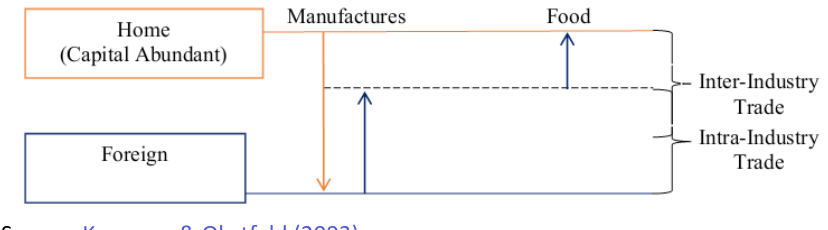
Figure 2: Patterns of Inter-Industry Trade and Intra-Industry